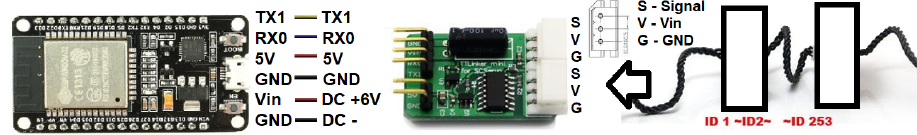
Figure 2. Schematic presentation of Feetech mini-board TTLinker used for connecting SCS15 servos.